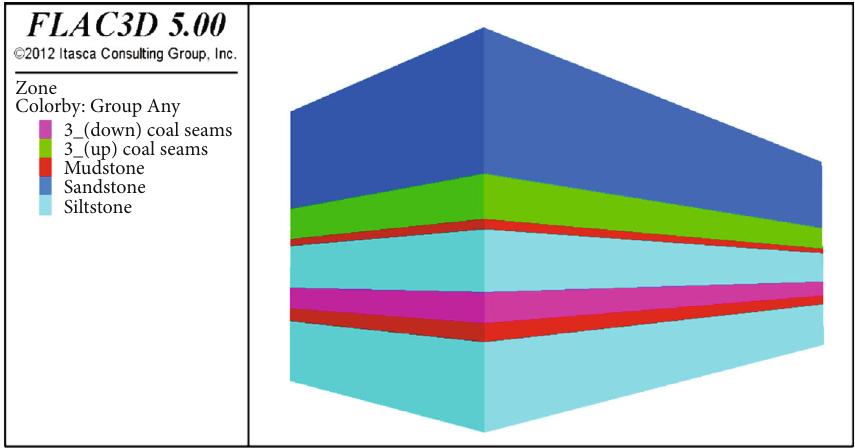
Figure 12: Numerical simulation model of mining